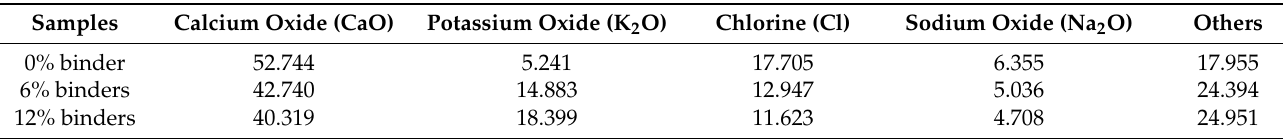
Table 1. X-ray fluorescence analysis of major and trace element in weight percentages using Omnian method with pressed powder pellet.